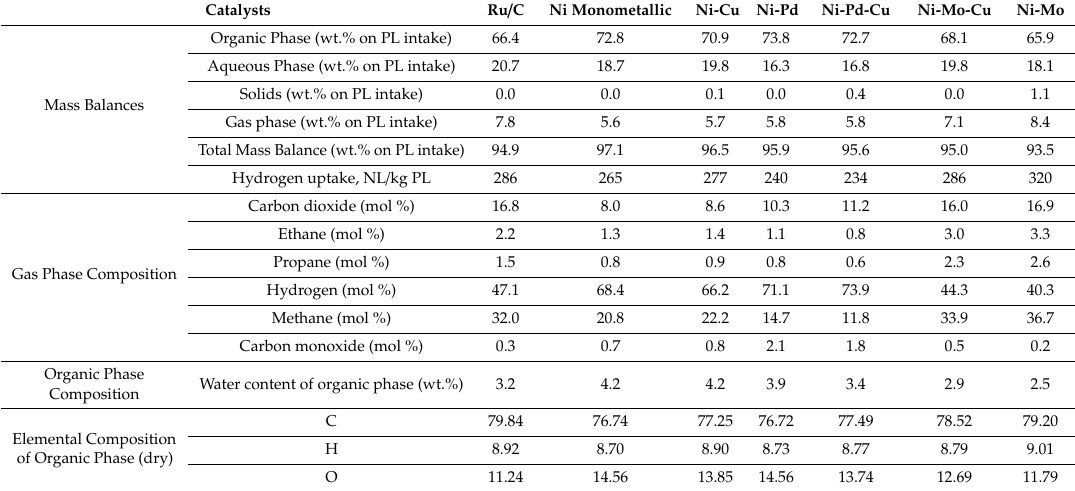
Table 5. Overview of the experiments for the catalytic hydrotreatment of PL. Catalysts